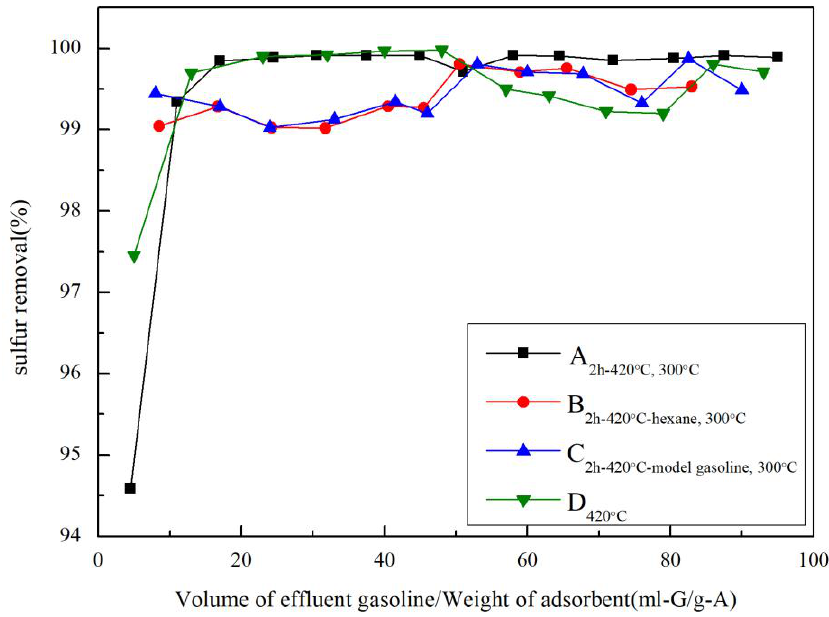
Figure 8. Desulfurization curves of unreduced adsorbents under different conditions: (A) pretreated for 2 h in H 2 at 420 ◦ C; (B) pretreated for 2 h in H 2 along with n-hexane at 420 ◦ C; (C) pretreated for 2 h in H 2 along with model gasoline at 420 ◦ C (D) without pretreatment at 420 ◦ C reaction temperature.